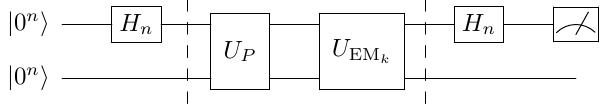
Figure 2: Quantum circuit for Simon -attack on